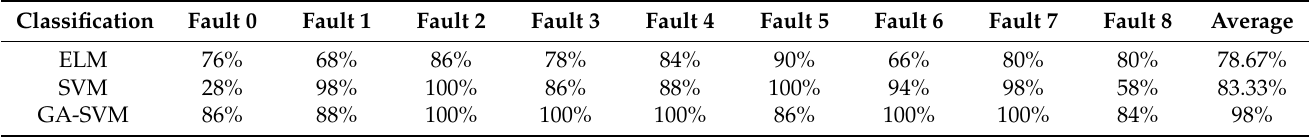
Table 3. Fault diagnosis accuracy rates of different classification methods.